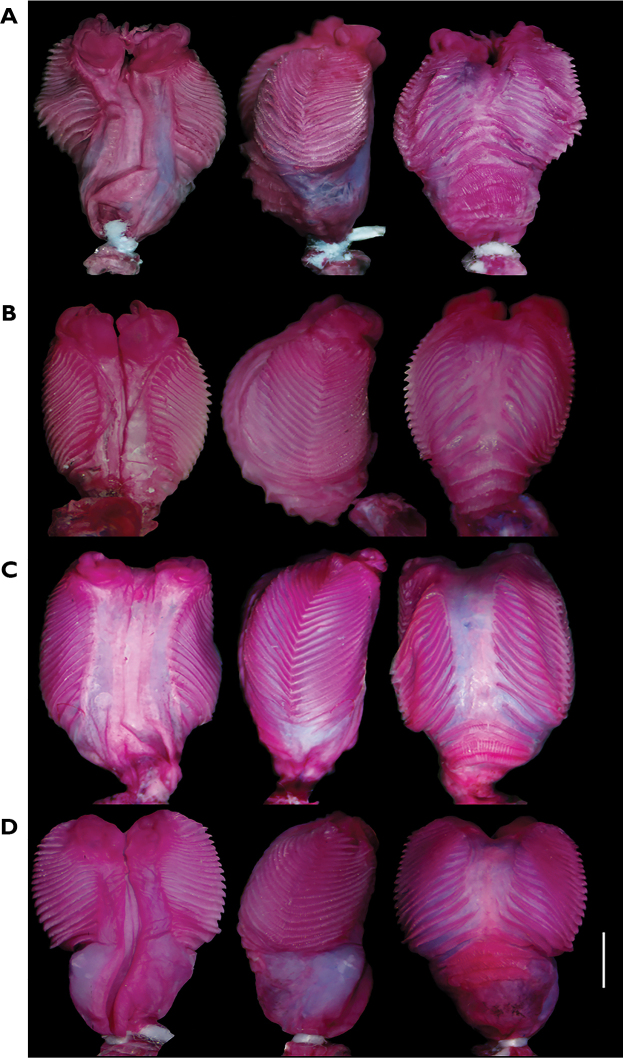
Comparative hemipenial morphology of Pholidobolus. Sulcate (left), lateral (center) and asulcate (right) views of: APholidobolus
samek sp. nov. (QCAZ 14955) BPholidobolus
condor sp. nov. (QCAZ 15844) CPholidobolus
dolichoderes sp. nov. (QCAZ 16353) DPholidobolus
fascinatus sp. nov. (QCAZ 15120). Scale bar: 1 mm.